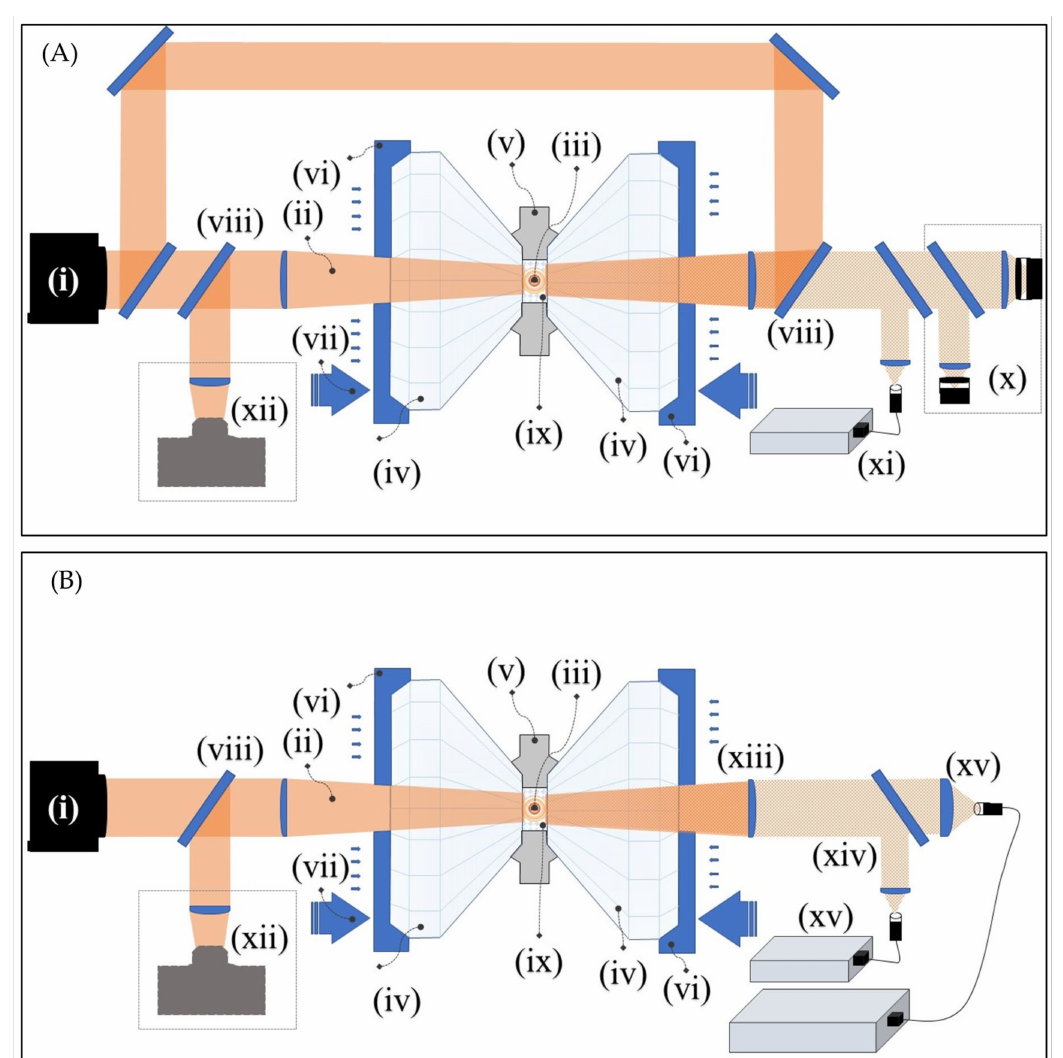
Figure 5. ( A ) Typical arrangement of Laser-Heated Diamond Anvil Cell (LH-DAC) systems for scientific/engineering experiments. ( B ) A common configuration for Laser (spectroscopic) Character- isation through Diamond Anvil Cell (LC-DAC) systems. The various elements of these systems are described in the text. Please see article text for component